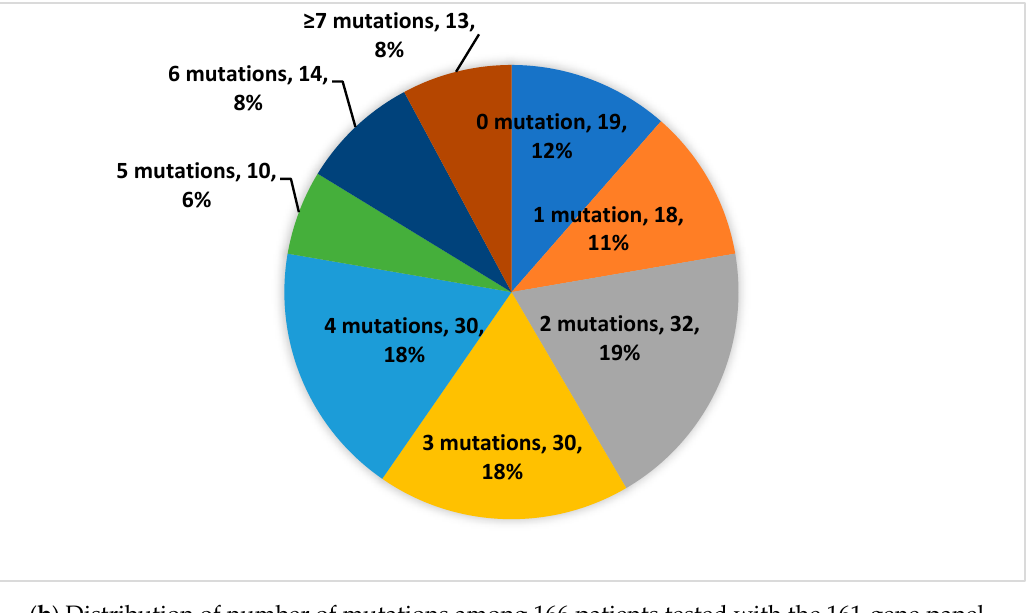
( b ) Distribution of number of mutations among 166 patients tested with the 161-gene panel. Figure 1. Distribution of number of mutations among the patients. Figure 1. Distribution of number of mutations among the patients. Table 3. Detected molecular Table 3. Detected molecular alterations.